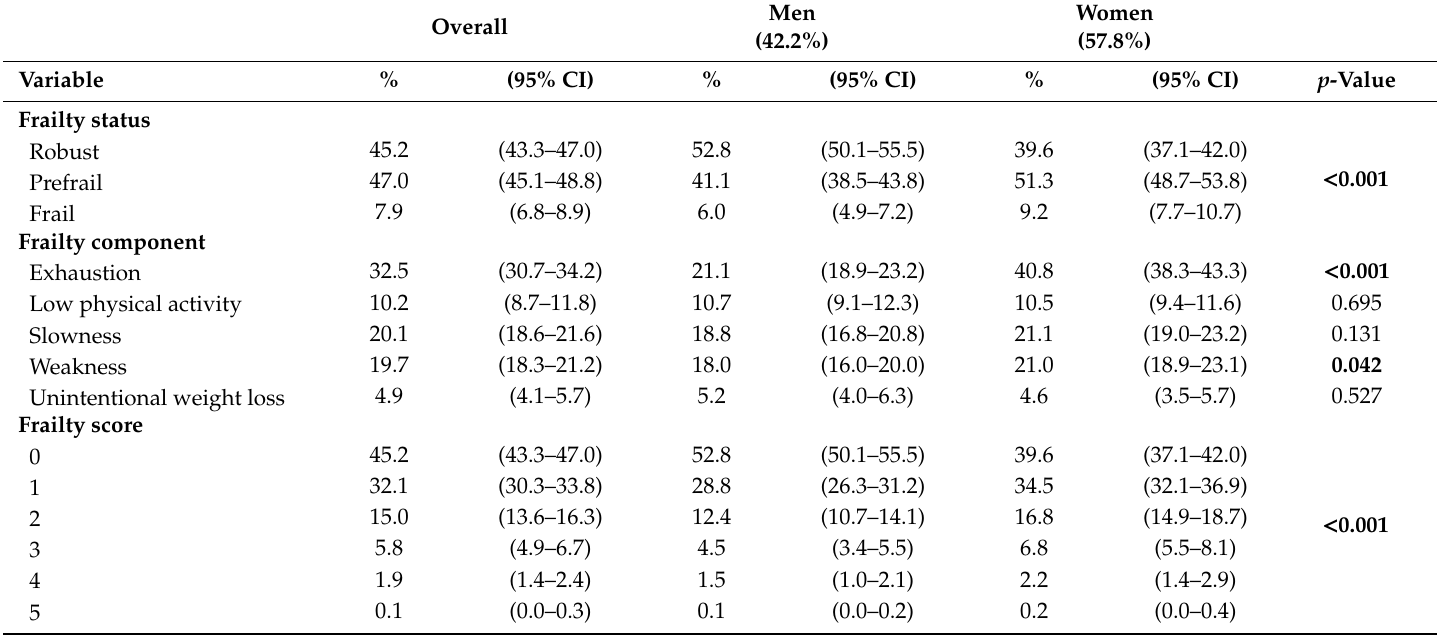
Table 2. Prevalence of frailty status and component (standardized